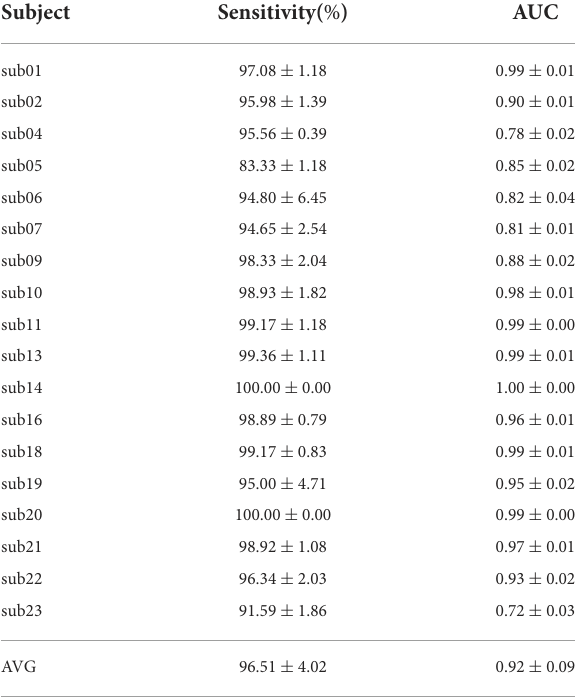
TABLE 1 Seizure prediction results of Graph Convolutional Networks (GCN) for feature combinations.